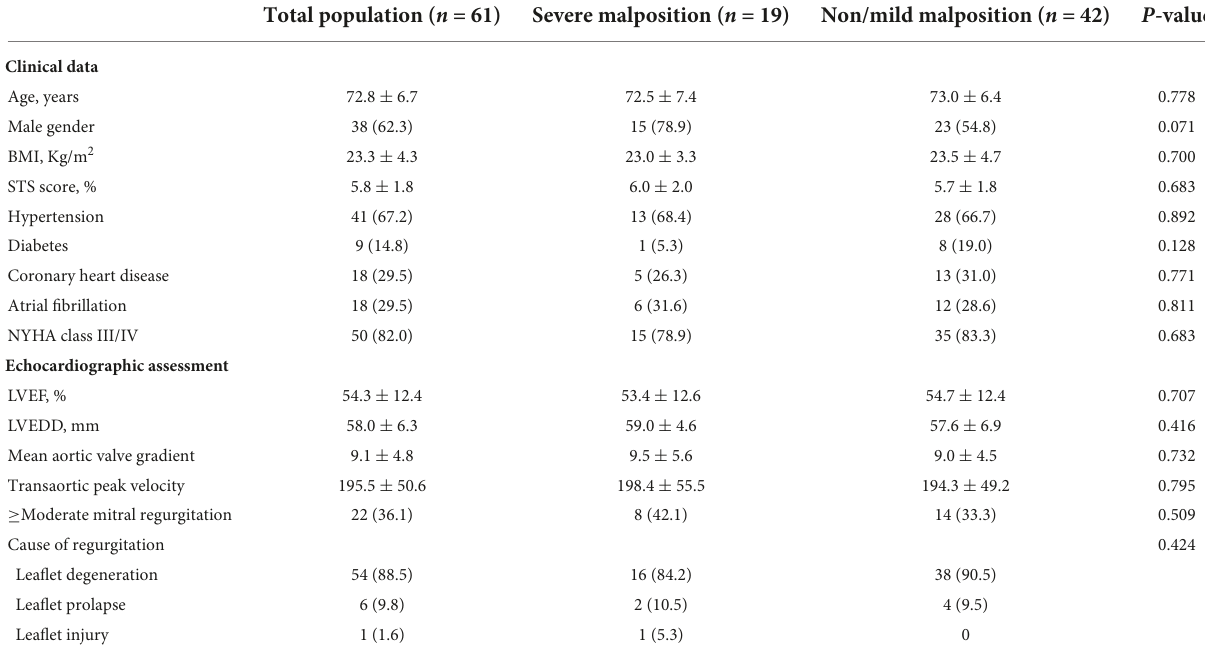
TABLE 1 Baseline characteristics of study